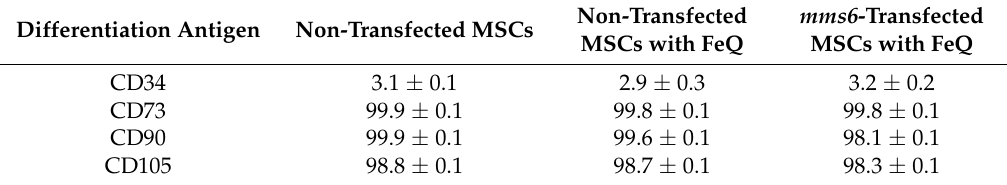
Table 1. Expression of MSC differentiation antigens following 21 days in culture. Wild-type or transfected MSCs were cultured in the absence or presence of ferric quinate.